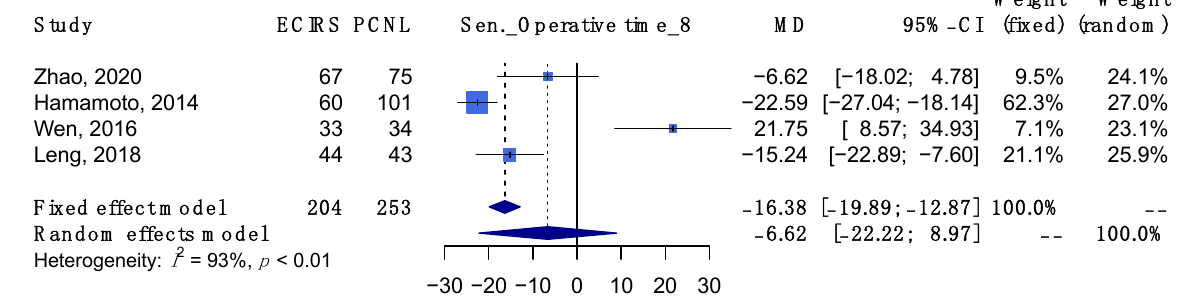
Figure A35. Sensitivity analysis of outcome regarding operative time. ([17–19,22]).